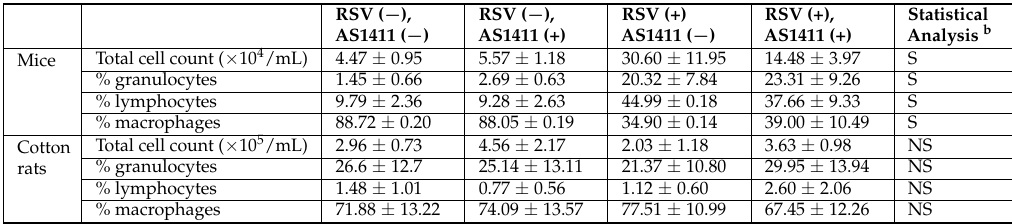
Table 1. BAL cytology for mice and cotton rats a .